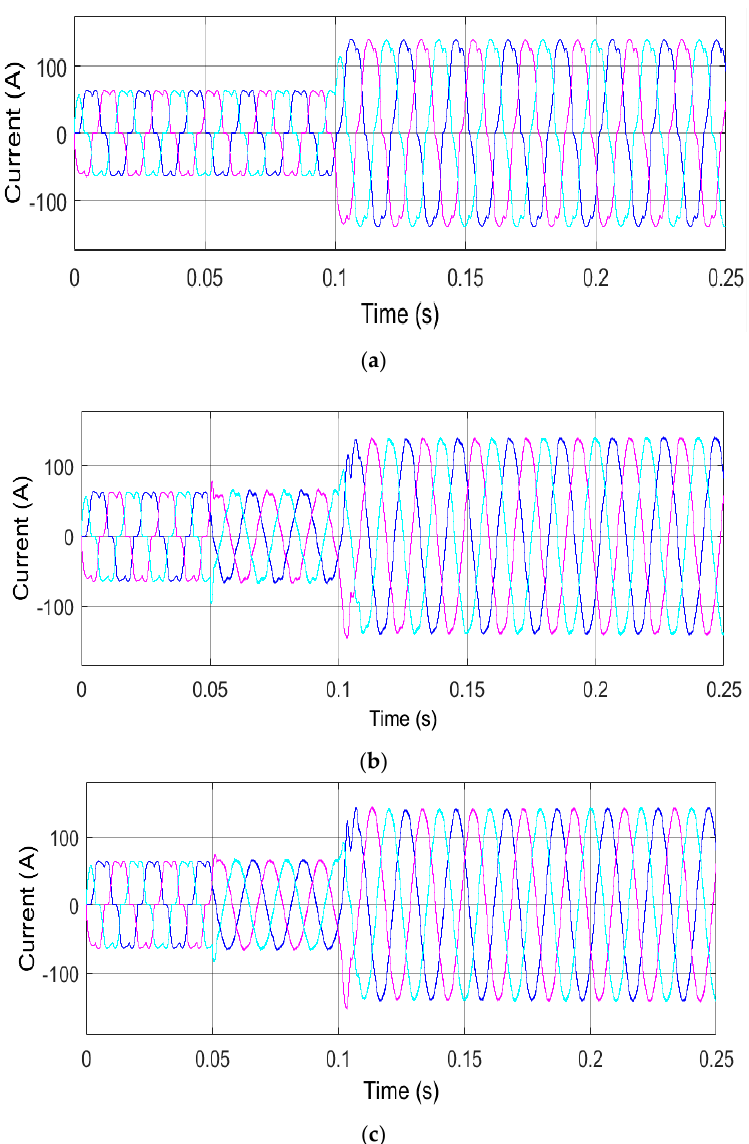
Figure 11. The current waveform of the grid side and load side. ( a ) Load current waveform uncompensated. ( b ) Grid current waveform compensated based on standard PSO algorithm. ( c ) Grid current waveform compensated based on CPSO-MAS algorithm.